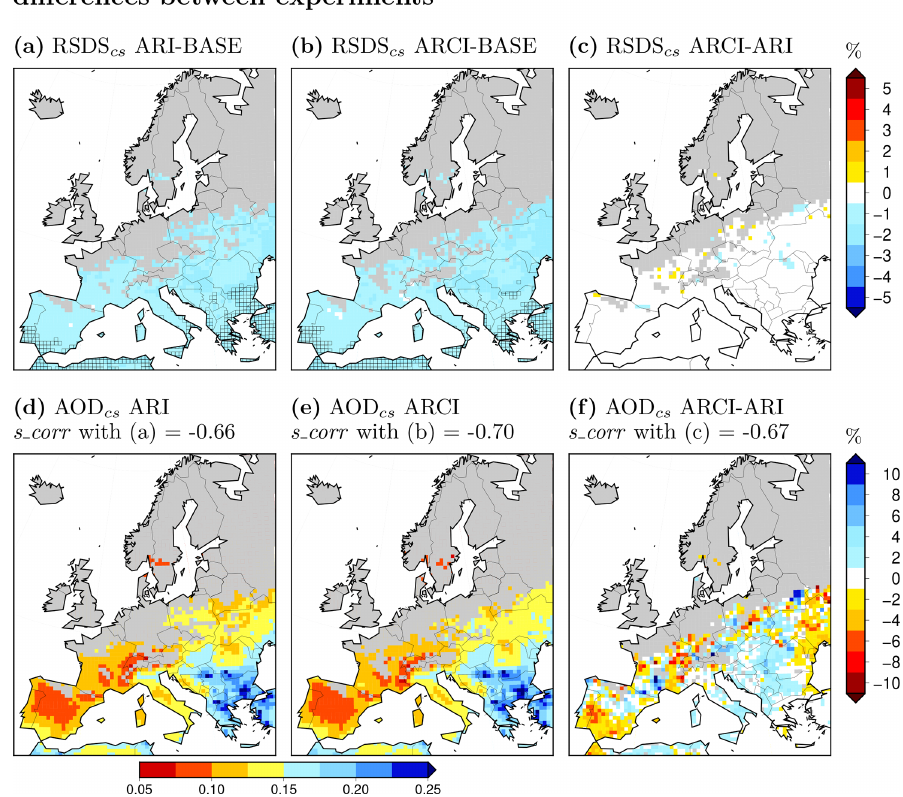
Figure 6. Relative differences between the WRF simulations in the RSDS cs (a–c) and AOD cs (at 550nm) (d–f) summer (JJA) climatologies; this is under clear-sky conditions in the historical period (1991–2010) and squared if statistically significant ( p < 0.05; units: percent). Note that panels (d) and (e) refer to the horizontal color bar just below them and simply represent the AOD summer climatologies in ARI and ARCI, respectively. Gray shaded areas depict grid points for which less than 75% of the summer mean values in the time series of RSDS cs and AOD cs were not missing. Spatial correlations ( s_corr ) between the patterns in the second row and the respective patterns in the first row are indicated in the